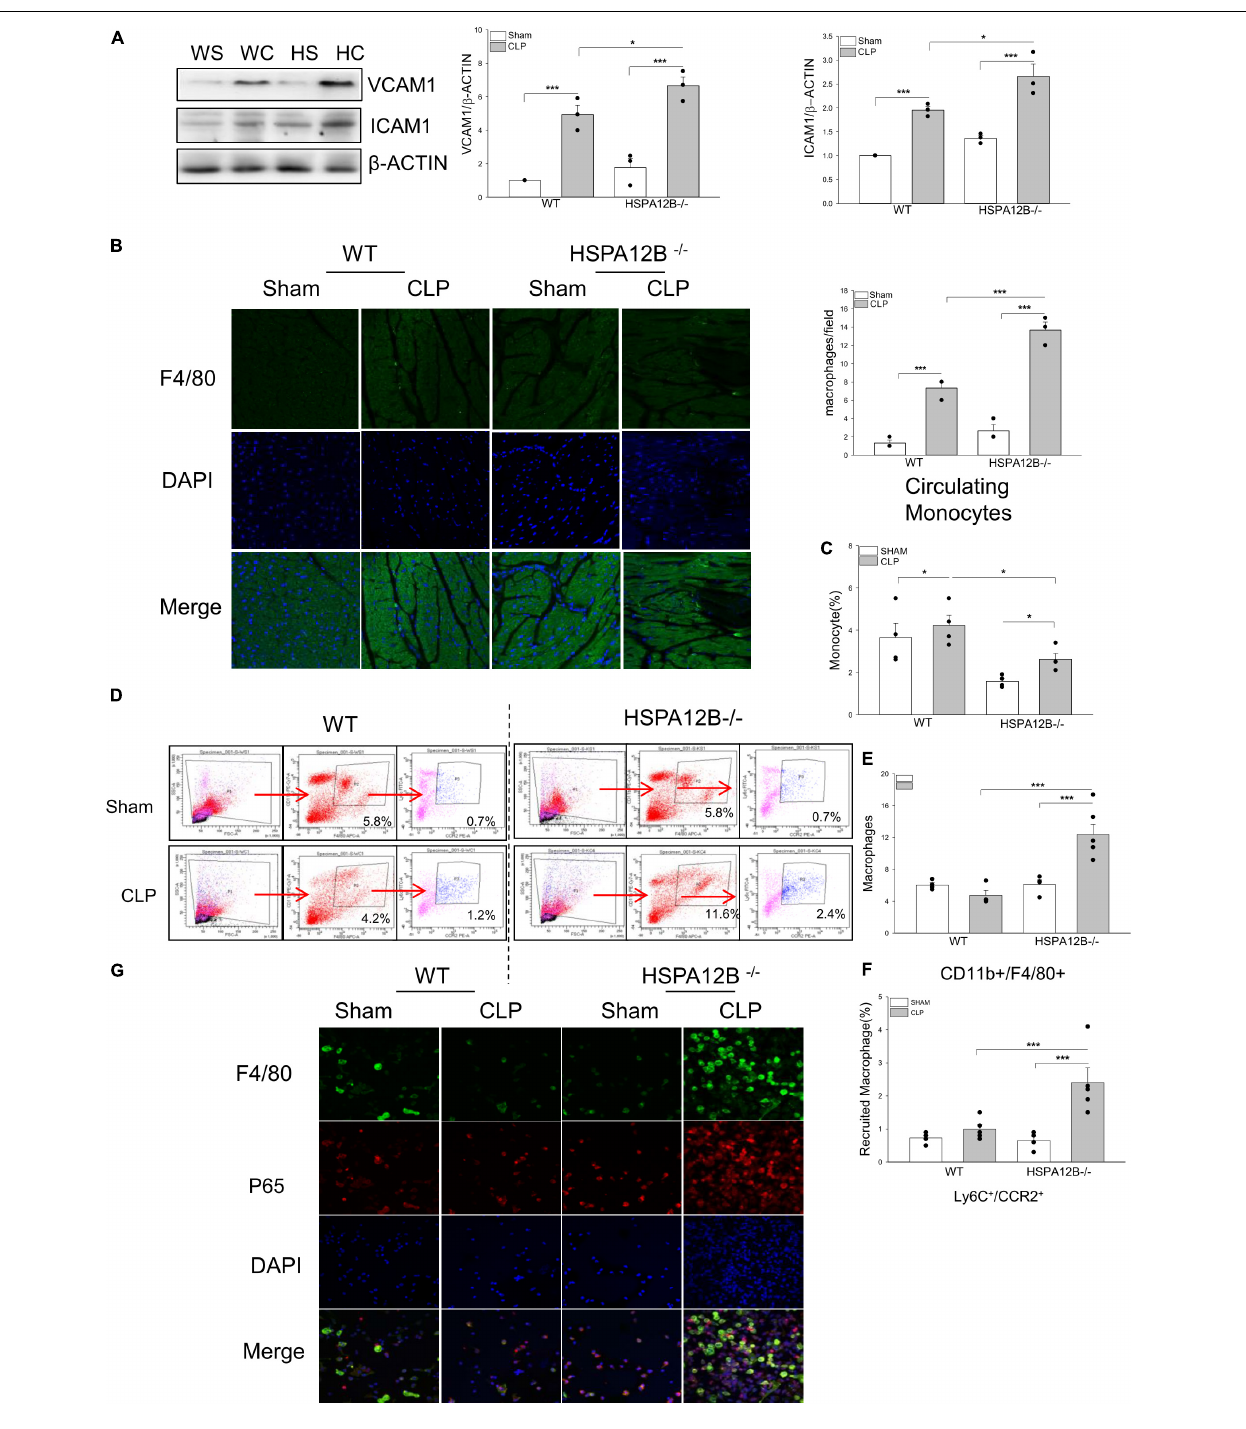
FIGURE 2 | Increased macrophage populations in the myocardium, circulation and spleen in HSPA12B − / − septic mice. WT and HSPA12B − / − mice were subjected to a CLP sepsis. Blood, spleen, and heart tissues were harvested at 36 h after CLP for the examination of macrophage populations. (A) Western blot analysis of myocardial vascular cell adhesion molecule-1 (VCAM-1) and intercellular adhesion molecule (ICAM-1). n = 3/group. (B) Heart tissues were sectioned and stained with anti-F4/80 antibody (green). Nucleus were stained with DAPI (blue). n = 3/group. (C) Flow cytometry analysis of the monocytes in blood (C) and the macrophages in spleen (D) with anti-CD11b + F4/80 + antibodies (E) and the pro-inflammatory macrophages in spleen with anti-Ly6C + /CCR2 + antibodies from CD11b + F4/80 + macrophages (F) n = 3 ∼ 5/group. (G) Immunofluorescent staining of peritoneal macrophages from septic mice, with anti-F4/80 antibody (green), and anti-p65 antibody (red). Nucleus were stained with DAPI (blue). WS, WT sham; WC, WT CLP; HS, HSPA12B − / − sham; HC, HSPA12B − / − CLP. * P < 0.05 and *** P < 0.001 compared with indicated